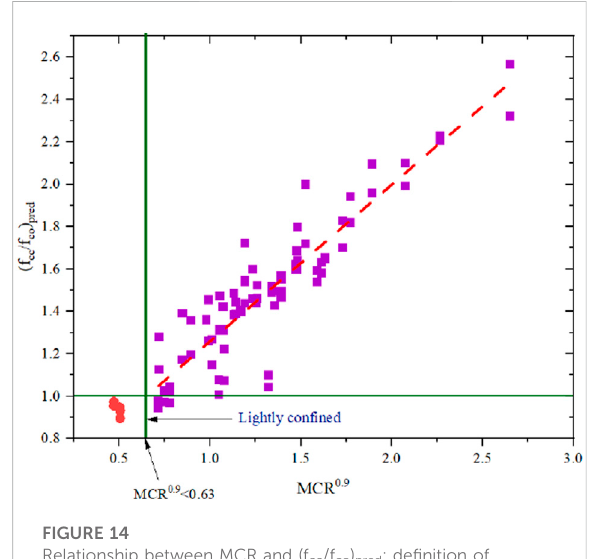
FIGURE 13 Estimation of PVC con fi ned